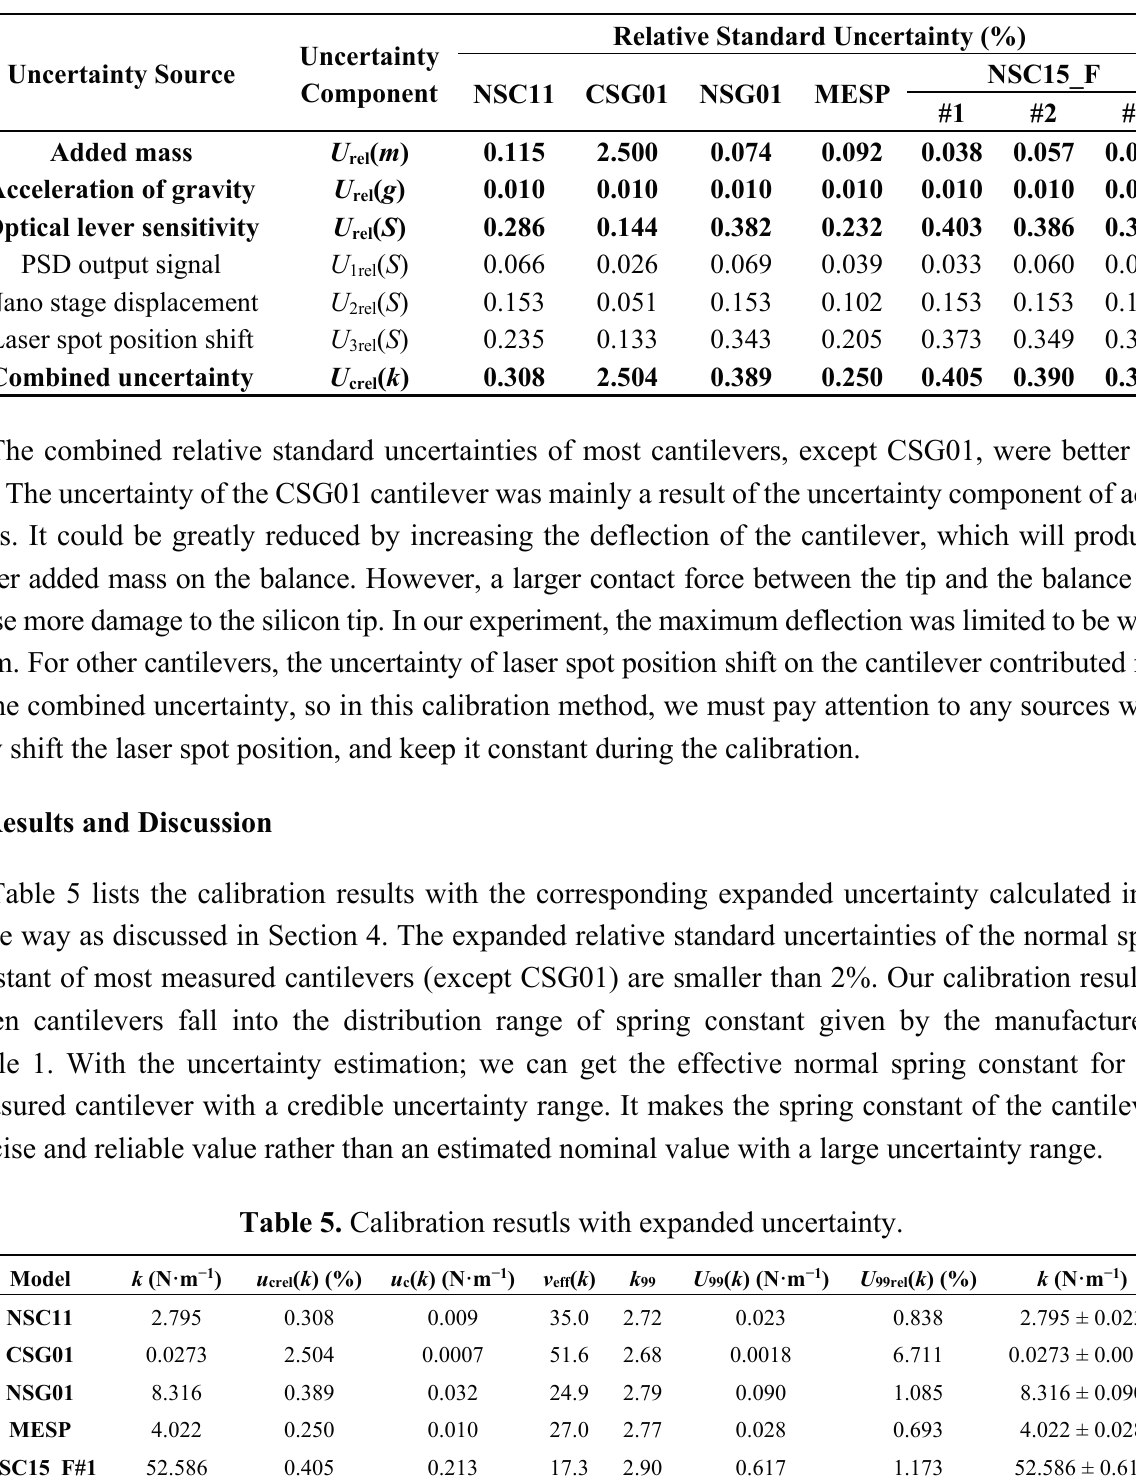
Table 4. Uncertainty sources and the contribution to the combined uncertainty for seven cantilevers.